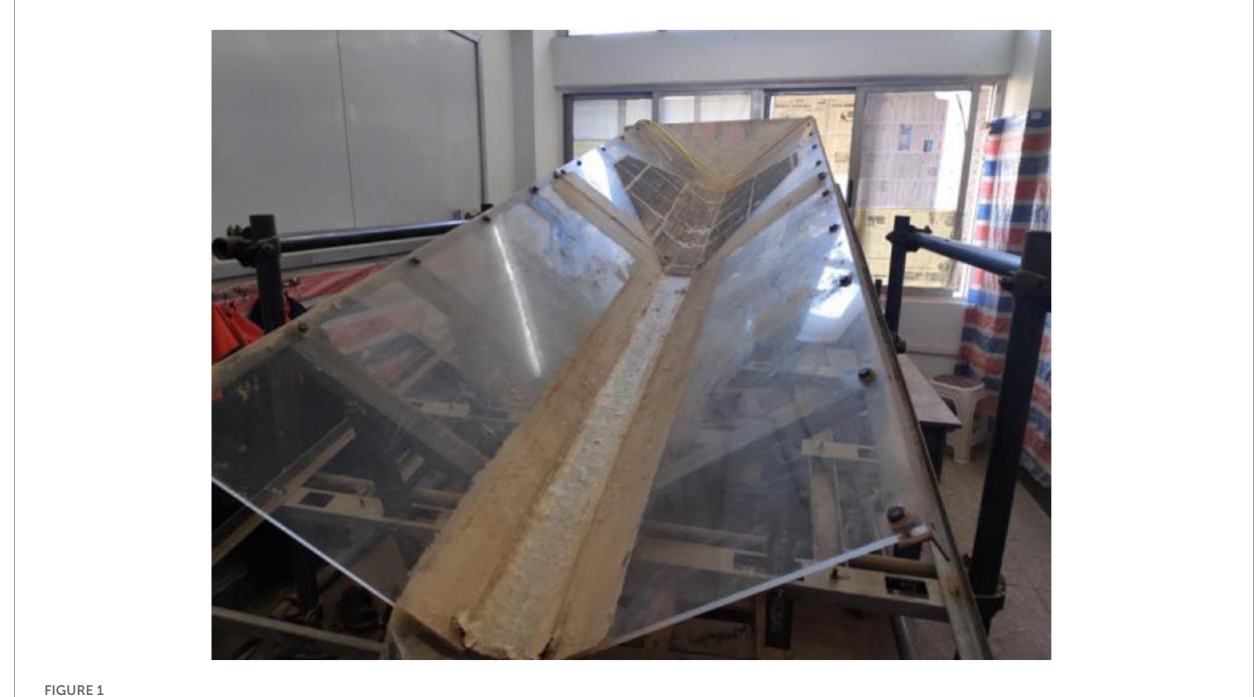
FIGURE1 The flume model.